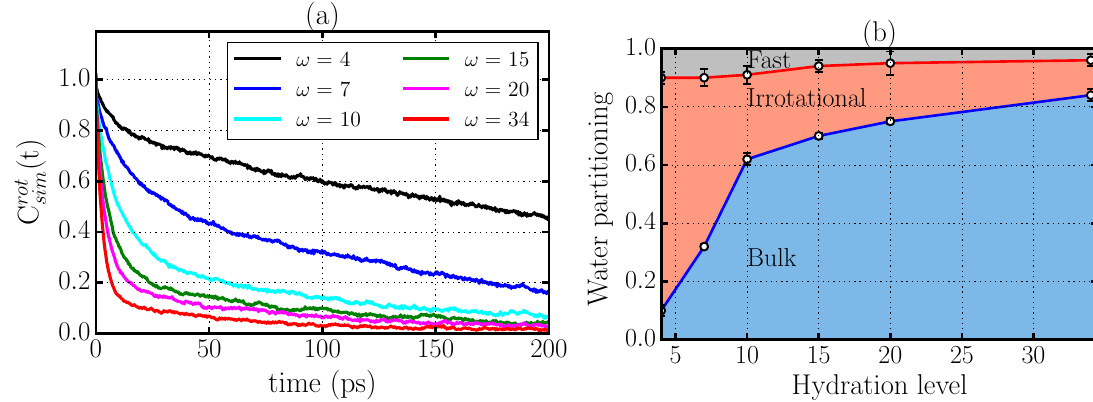
Figure 3. ( a ) rotational dipolar correlation function of water molecules calculated from simulations of DMPC phospholipid bilayers with different levels of hydration ω ; ( b ) the partition of all the water in the system into the fractions (i) f bulk of bulk-like (lower circles); (ii) f irr of irrotational (upper circles) and f bulk f irr of fast water molecules, as a function of the hydration level ω in Equation (5), (iii) f fast = 1 − − following the decomposition of the rotational correlation function proposed in Ref. [10]. The dots represent the partitioning from MD simulations. Full lines are guides for the eyes. Table 2. The five parameters of the fits for the rotational dipolar correlation function C rot resulting from MD simulations of stacked membranes with different hydration level ω